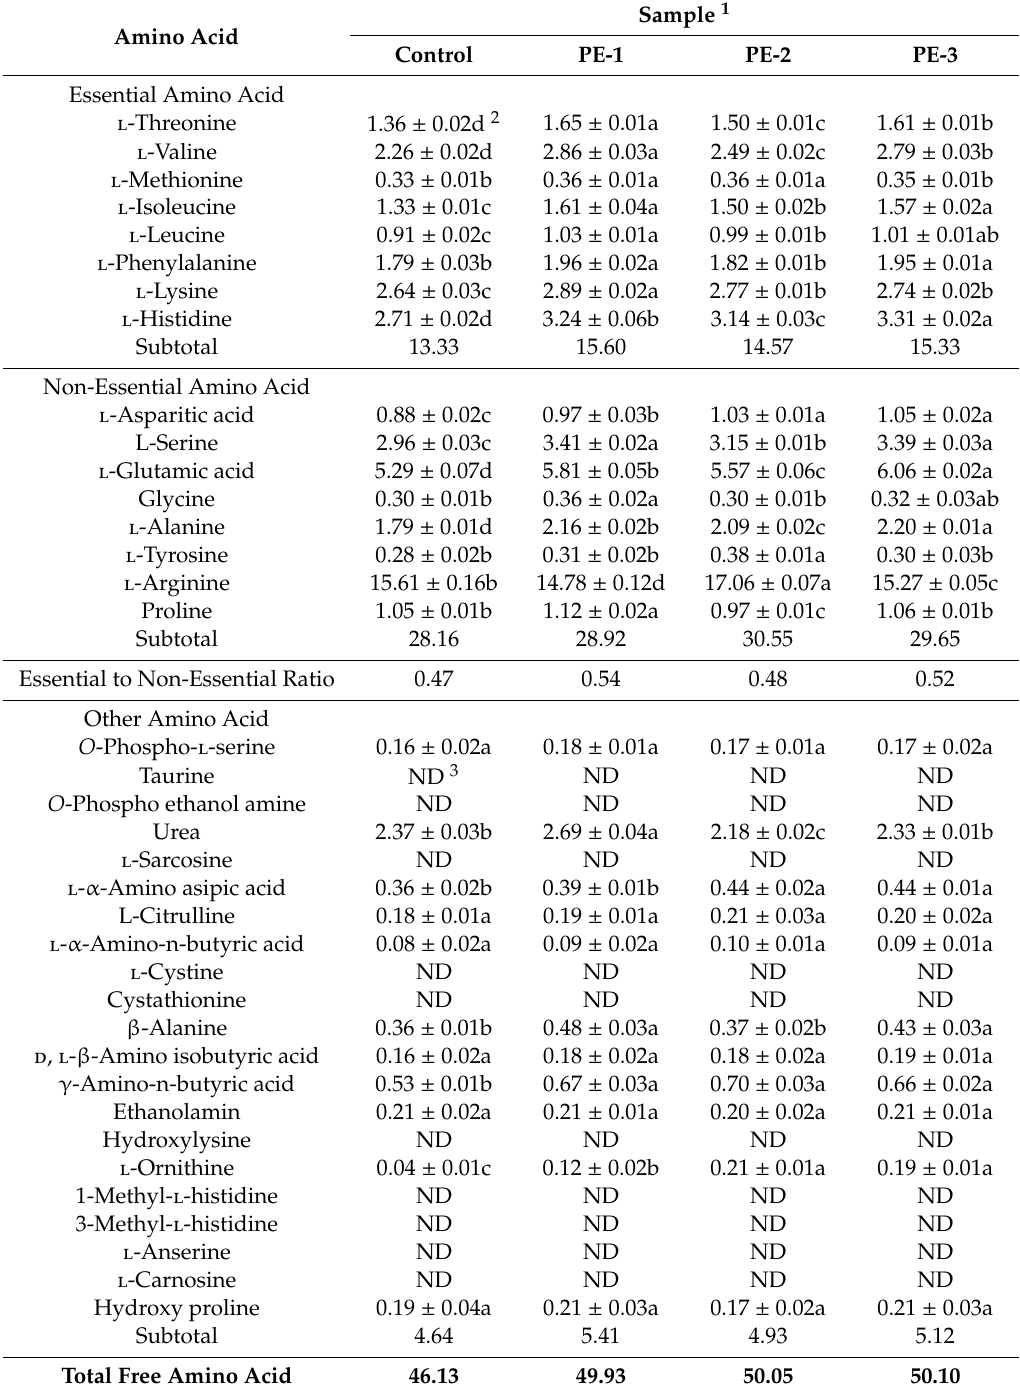
Table 3. Free amino acid composition (mg / g of dry weight) of soybean sprouts grown after seed-soaking in di ff erent concentrations of Pu-erh tea extracts. PE-1, PE-2, and PE-3: 1%, 2%, and 3% ( w / v ) Pu-erh tea extract contractions,